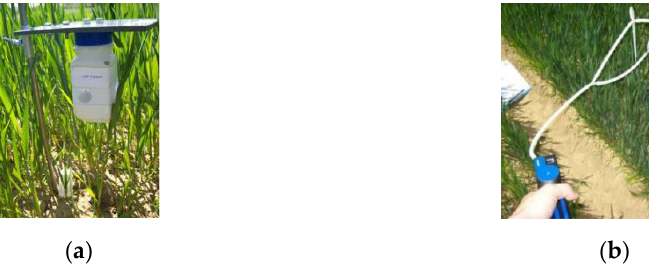
Table 4. Overview of NH 3 measurements in a 2-year study in 2011 and 2013.